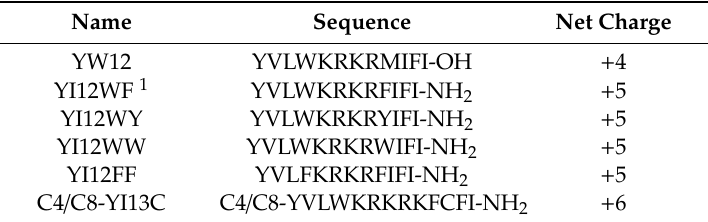
Table 3. De Novo Designed β -boomerang